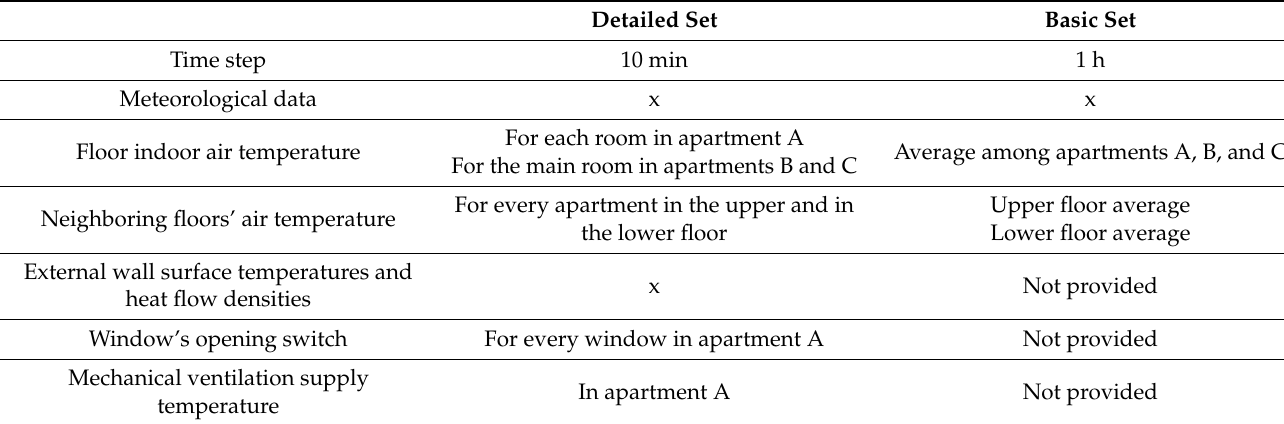
Table 2. Detailed and basic measurement data